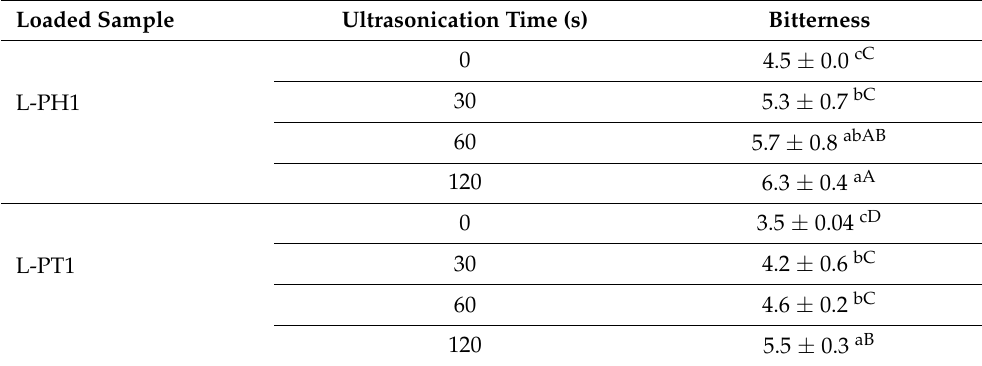
Table 4. Bitterness of SFPH (L-PH1)- and SFPT (L-PT1)-loaded liposomes treated with ultrasound assisted process